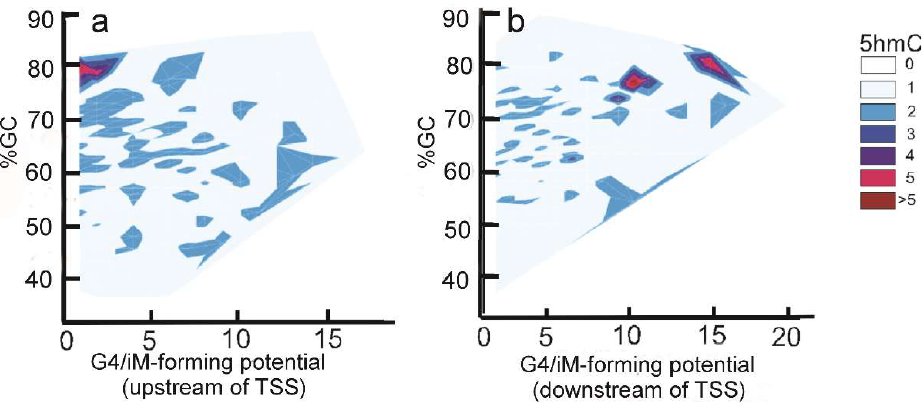
Figure 2. Positional dependence of iM and 5hmC localization. ( a ) The overall density of iM-forming sequences relative to the TSS. ( b ) The density of iM-forming sequences with 5hmCs co-localized within 100 bp of a putative iM.